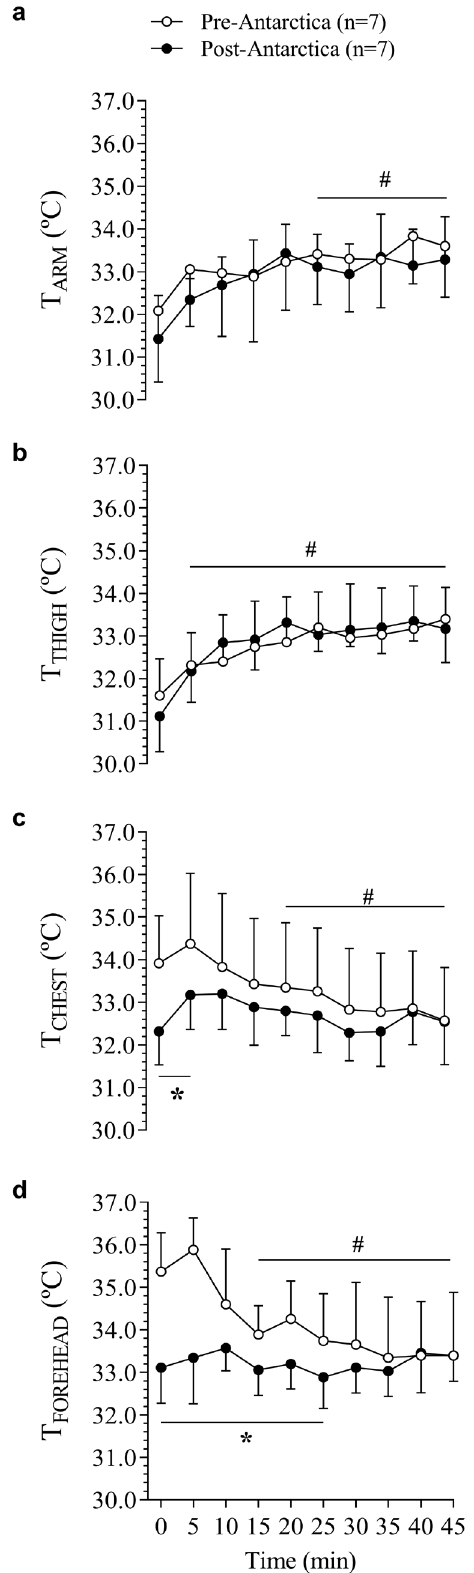
Figure 3. Skin temperatures (T ) during the exercise SK heat stress protocol performed before and after the Antarctic expedition (n = 7). The following variables ); b) thigh (T ), c) were measured: a) arm (T ARM THIGH ), and d) forehead (T ). *Significantly chest (T CHEST FOREHEAD different (P < 0.05) from the pre-Antarctica trial. # Significantly different (P < 0.001) between time points; and T , different from 0 min; for T at pre- for T ARM THIGH CHEST Antarctica, 30 th to 45 th min different from 0 to 10 th min, and 20 th to 25 th min different from 5 th min; for T FOREHEAD at pre-Antarctica, 15 th to 45 th min were lower than 0 and 10 th min. The data are expressed as means ±